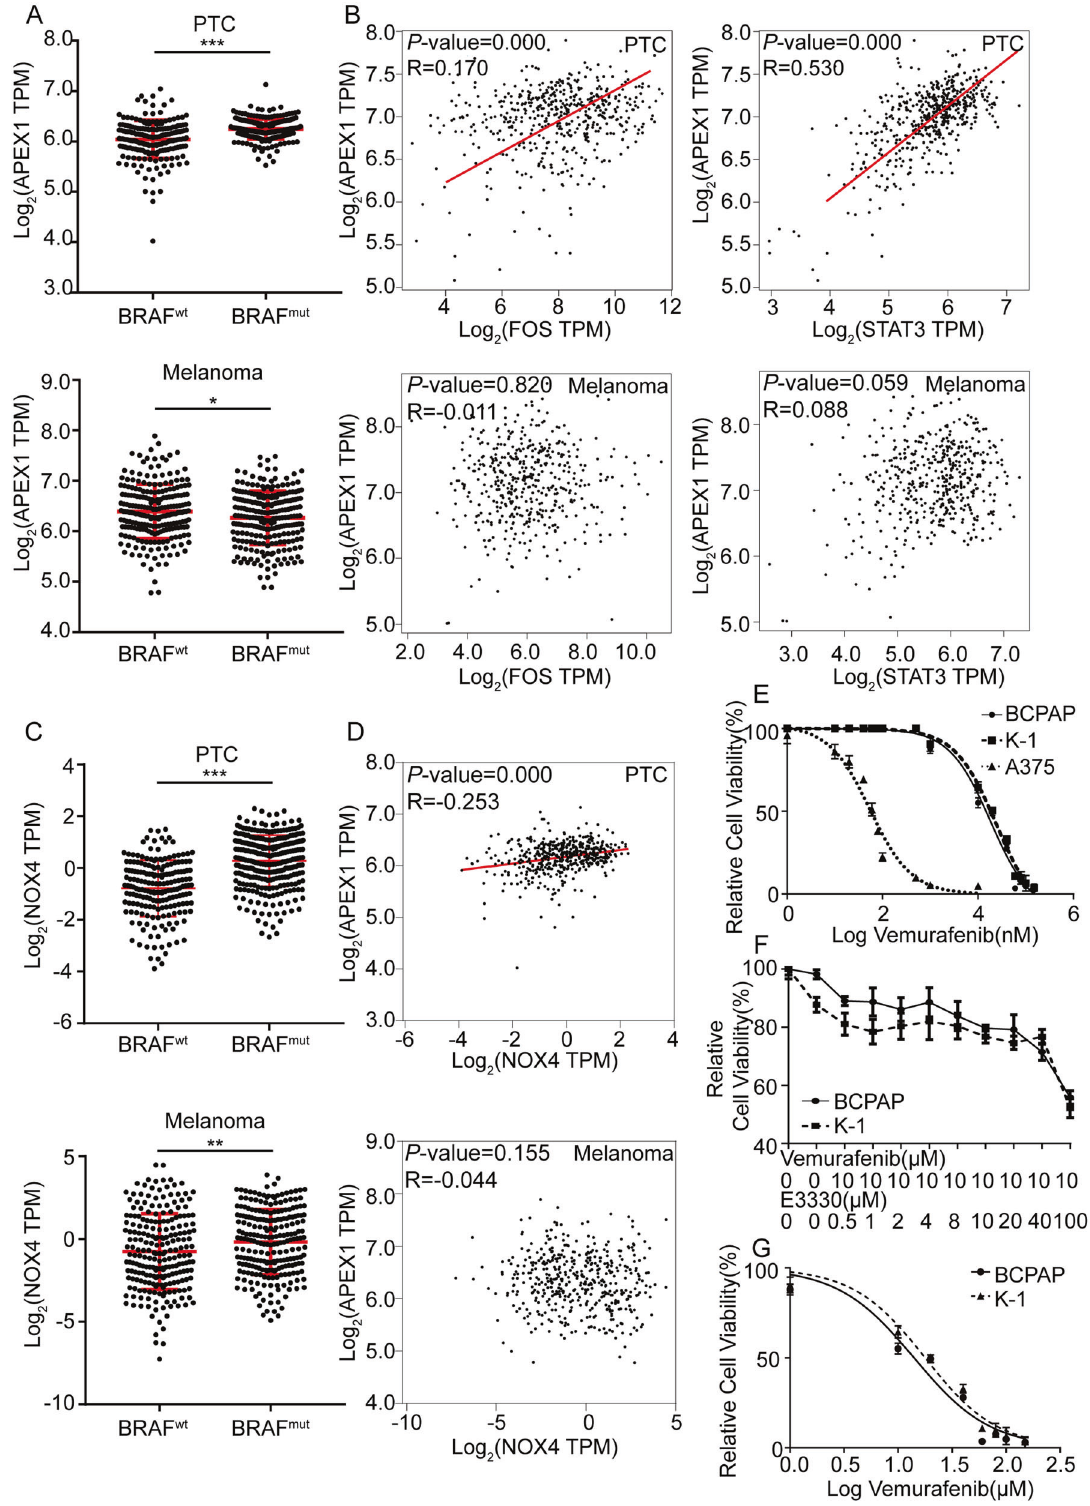
Fig. 2 Resistance to vemurafenib in PTC was related to upregulated Ref-1 expression. A Analysis of data from the TCGA database for Ref-1 mRNA expression levels in BRAF wt and BRAF mut PTC (upper) and melanoma (bottom) cases. B Correlation analysis of Ref-1 and MAPK pathway targeting genes expression in PTC (upper) and melanoma (bottom) cases based on the TCGA database. C Analysis of data from the TCGA database for NOX4 mRNA expression levels in BRAF wt and BRAF mut PTC (upper) and melanoma (bottom) cases. D Correlation analysis of Ref-1 and NOX4 mRNA expression levels in PTC (upper) and melanoma (bottom) cases based on the TCGA database. E Vemurafenib IC 50 detection by a CCK-8 assay in BCPAP, K-1, and A375 cells. F Cell proliferation ability detection by a CCK-8 assay after vemurafenib (10 μ M) and E3330 (different concentration gradient) pretreatment in BCPAP and K-1 cells. G Vemurafenib IC 50 detection after E3330 pretreatment by a CCK-8 assay in BCPAP and K-1 cells. * P < 0.05, ** P < 0.01. *** P < 0.001. Cell Death and Disease (2022)